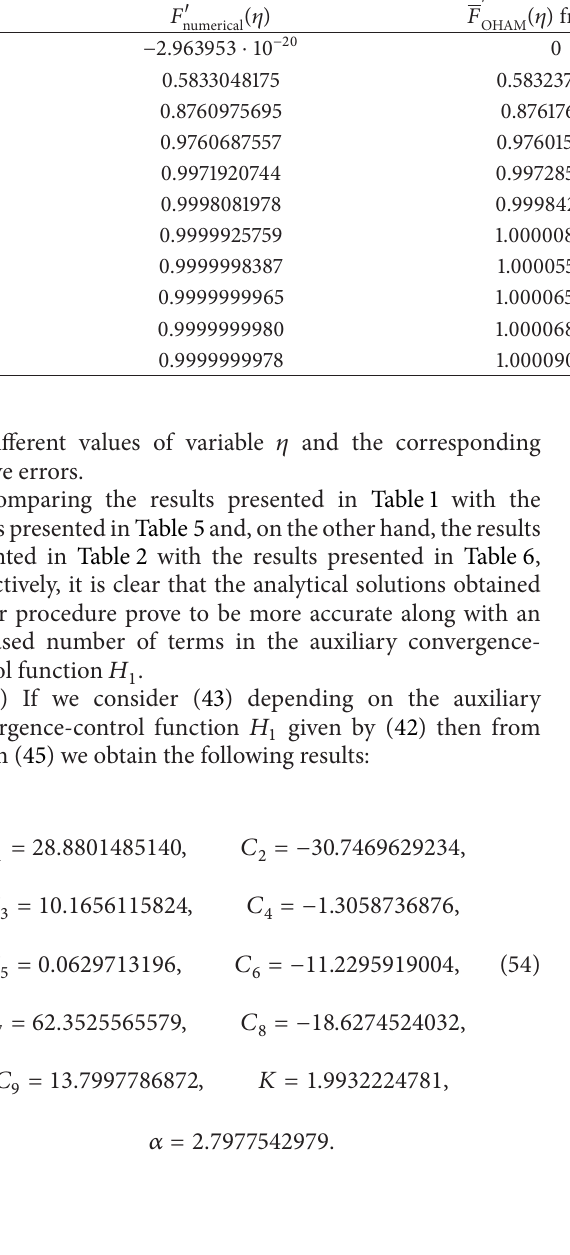
Table 6: Comparison between OHAM results for velocity 𝐹 𝜂 𝐹 󸀠 numerical